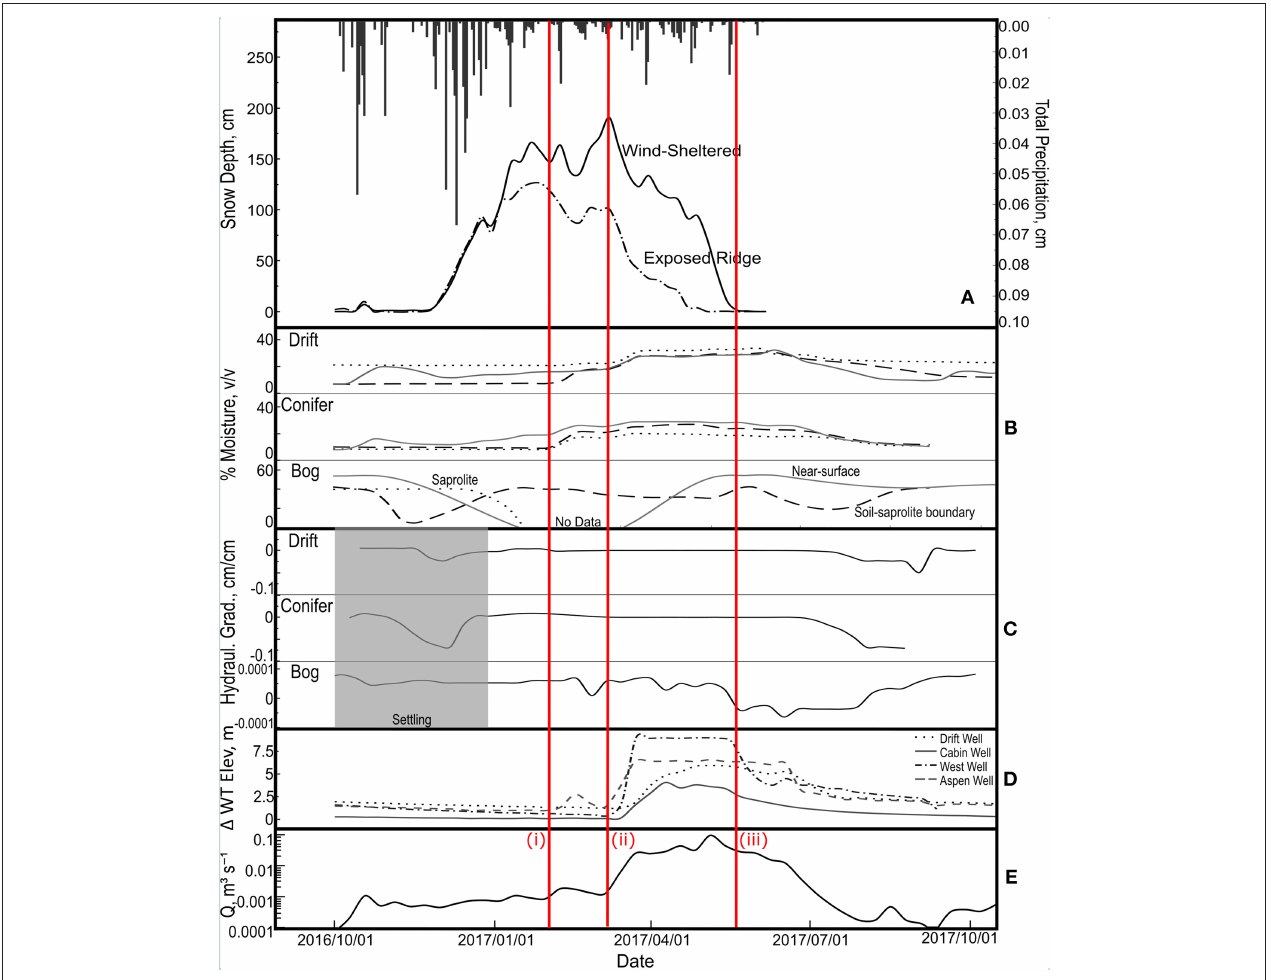
FIGURE 2 | RME inputs, outputs, and changes in storage during water year 2017. (A) Hyetograph on inverse right vertical axis and snow depth on left vertical axis at two sites, the exposed ridge (dashed line) meteorological station (176) and the wind-sheltered snow pillow site (solid line, station “rmsp”). Data from USDA ARS Northwest Watershed Research Center (2017a); USDA ARS Northwest Watershed Research Center. (2017b). (B) Volumetric soil moisture in soil pits—solid lines represent the near-surface measurement, dashed lines represent the soil/saprolite interface, and dotted lines represent the saprolite at all three sites (see Table 1 for installation depths). (C) Hydraulic gradient in soil pits between the 30-cm and soil-saprolite boundary matric potential sensors where common negative gradients indicate downward flow; data from a settling period after installation is grayed out. Note that the scale of the Bog pit differs from the others. (D) Water table elevation relative to lowest recorded level in each of four monitoring wells in RME. (E) Discharge at the catchment-defining weir. Vertical red lines highlight (i) the early March melt event and (ii) peak snow accumulation and increases in soil moisture and water table elevation associated with the onset of melt, and (iii) the end of snowmelt, with succeeding drops in soil moisture and water tables. Spline fits to all data are shown with λ = 0.05, except for wells and discharge panels in which λ = 0.00001; note that the y-axis of the discharge plot is